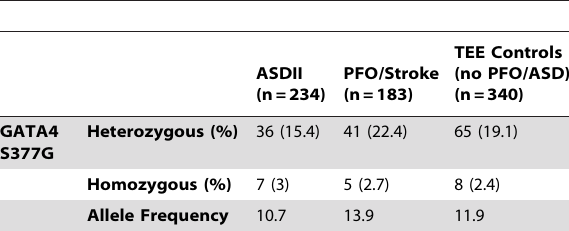
Table 6. Pooled genotype data from Australian and German